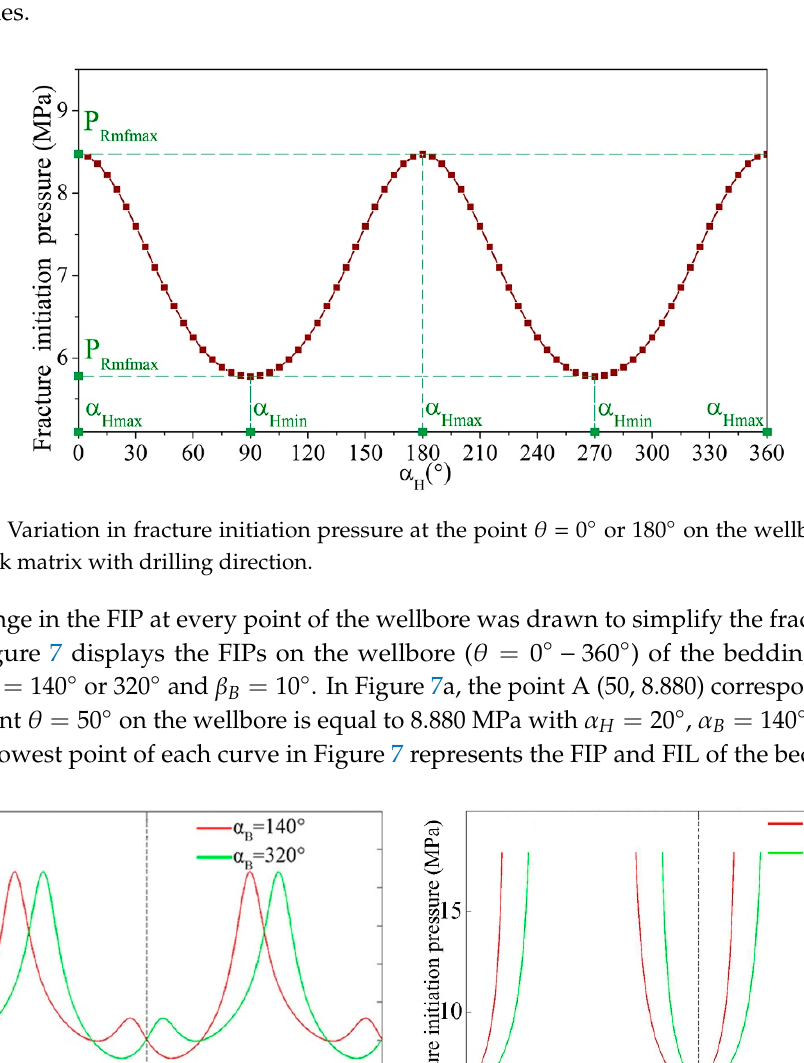
Figure 6. Variation in fracture initiation pressure at the point θ = 0° or 180° on the wellbore of the intact rock matrix with drilling direction.